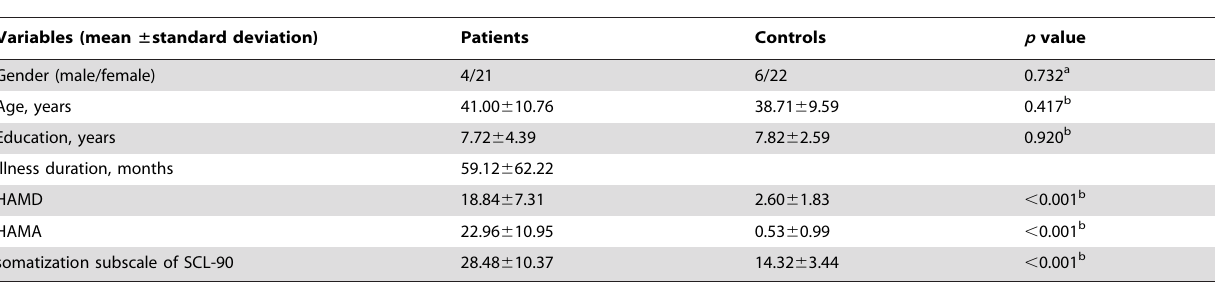
Table 1. Characteristics of the patients and healthy controls.